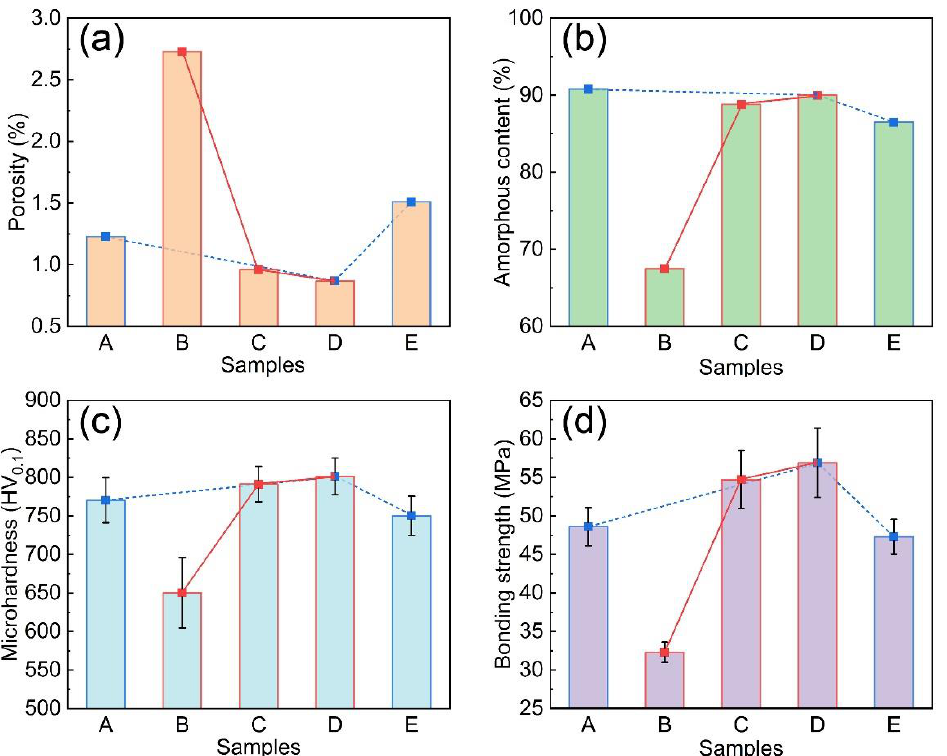
Figure 4. Porosity ( a ), amorphous content ( b ), microhardness ( c ), and bonding strength ( d ) of Fe-based AMCs on LA141 magnesium alloy.